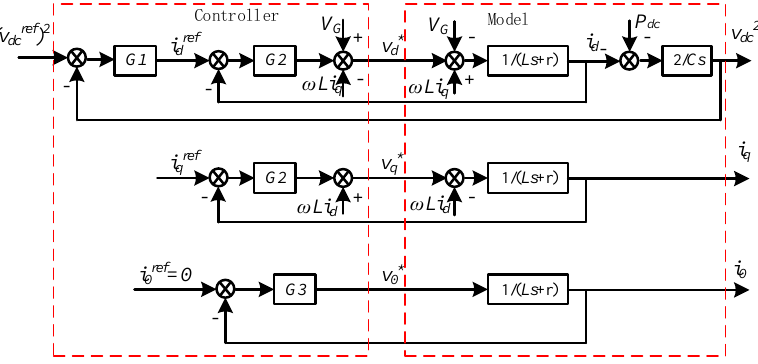
Figure 4. Inner loop control